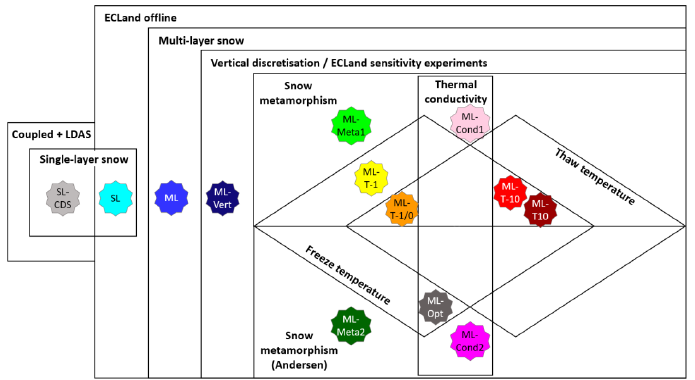
Figure 2. Experiments analyzed in this study, describing the main simulation features including the snow and soil scheme modifications for sensitivity analysis in permafrost. The experiments are displayed with the star shapes, using a short name and a color to help identifying them throughout the